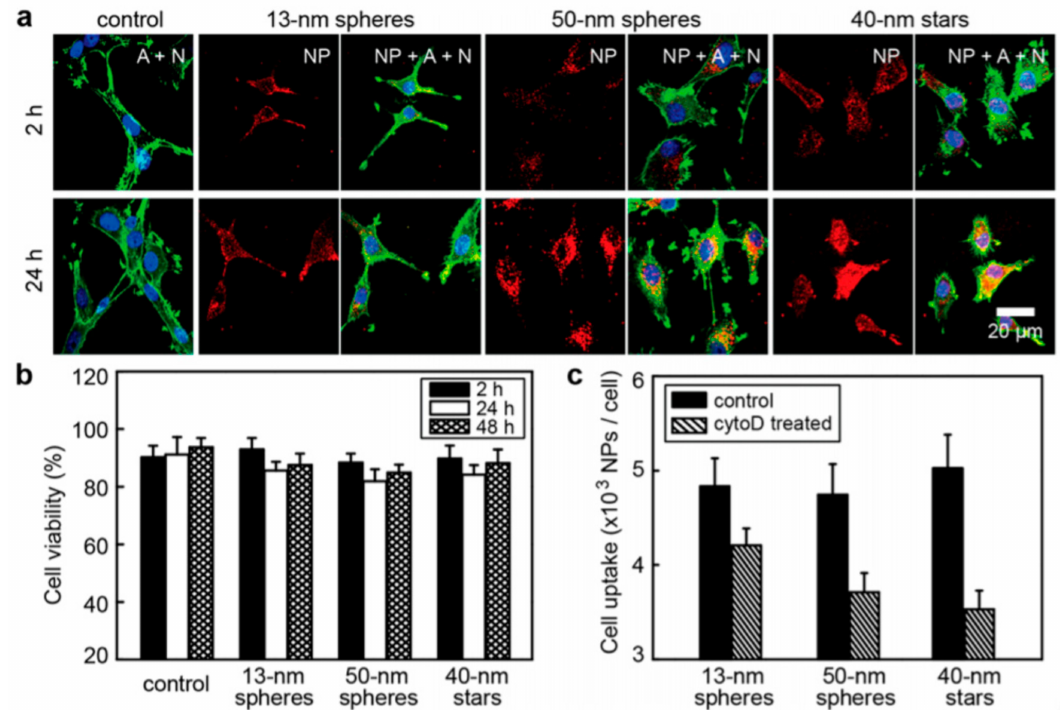
Figure 8. The anti-tumor activity of three NPs in vitro and cell morphology changes induced by larger constructs. ( a ) Con- focal microscopic images of U87 cells treated with PBS (control) or three NPs (0.2 nM). ( b ) The inhibitory effect of three NPs (0.2 nM) on U87 cells. ( c ) Effect of CytoD on the uptake of three NPs by U87 cells. Reprinted with permission from Yue et al. [132]. Copyright (2017) American Chemical